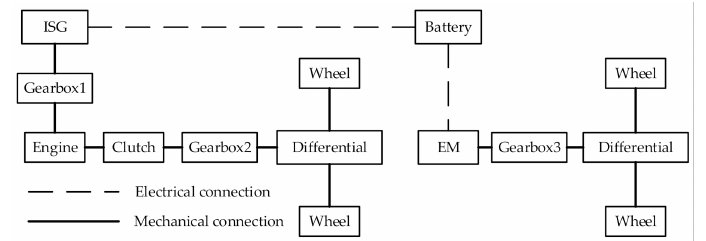
Figure 1. HEV powertrain